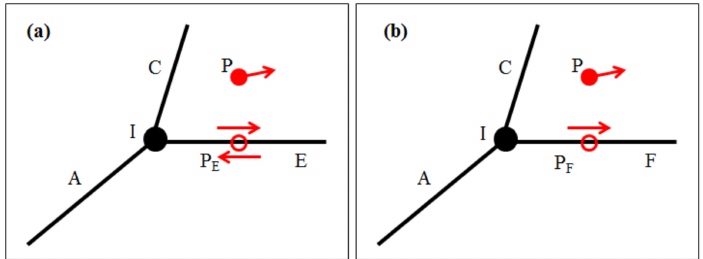
Figure 3. Comparison of azimuths between the observation points and the candidate points. The observation points are denoted by red solid circles. The candidate points are denoted by red hollow circles. The azimuths of the points are denoted by red solid arrows. The intersection among the CFs are denoted by black solid circles. The road segments E and F comprise a two-way road ( a ) and a one-way road ( b ),